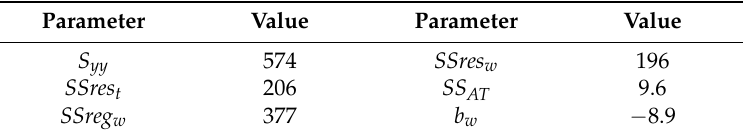
Table 6. Summary of calculations for test laboratories comparison. SS : Sum of squares.